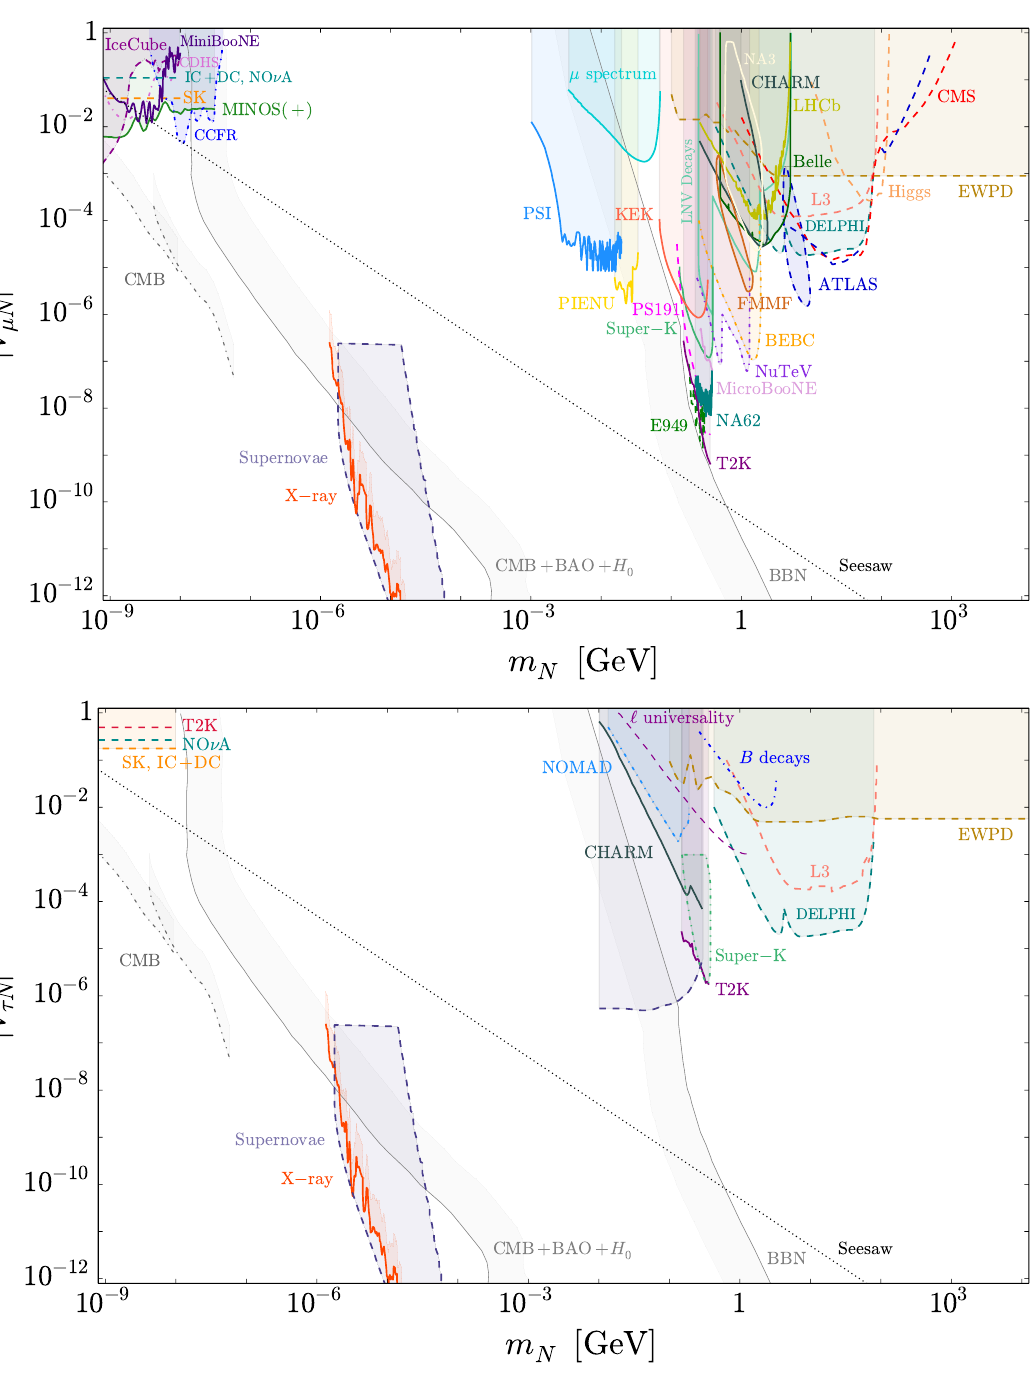
Figure 13 . Constraints on the mass m N of the sterile neutrino and its squared mixing with the muon neutrino (above) and excluded by the searches listed in the